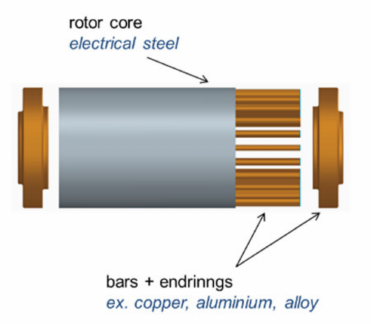
Figure 2. Constructional layout of a laminated rotor induction